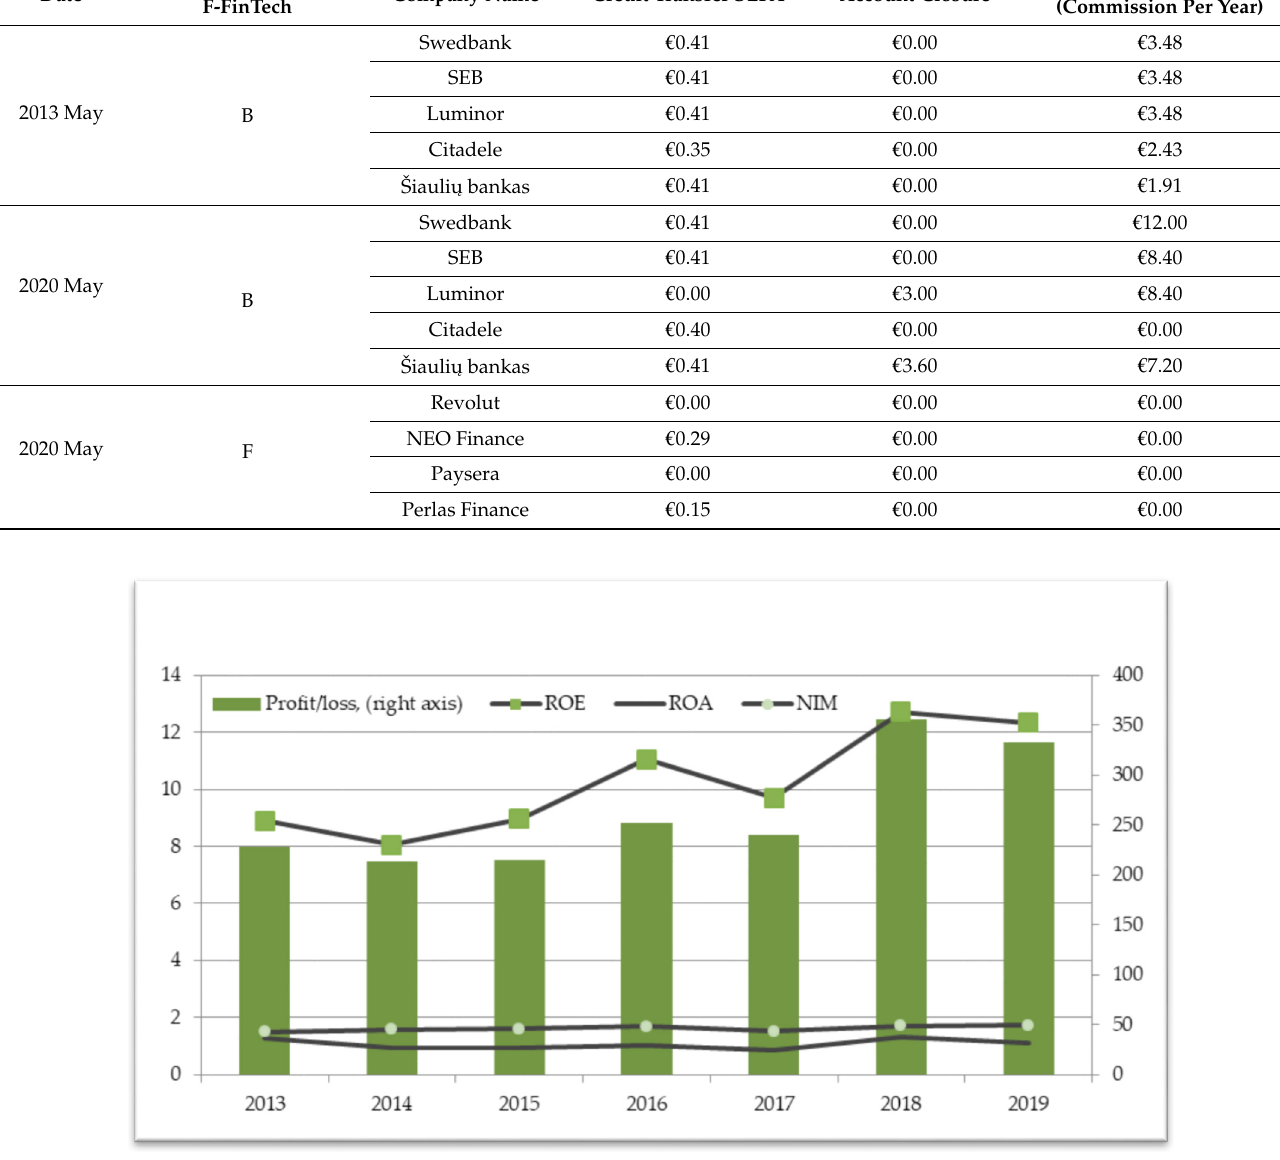
Figure 6. The dynamics of banking sector profit (loss) of the current year, millions EUR and return on equity (ROE), return on assets (ROA) and net interest margin (NIM), percent. Table 4. Profit (loss) of the current year and descriptive statistics of Lithuanian banking sector in the period of 2013–2019. Profit (Loss) of the Current Year, Millions EUR